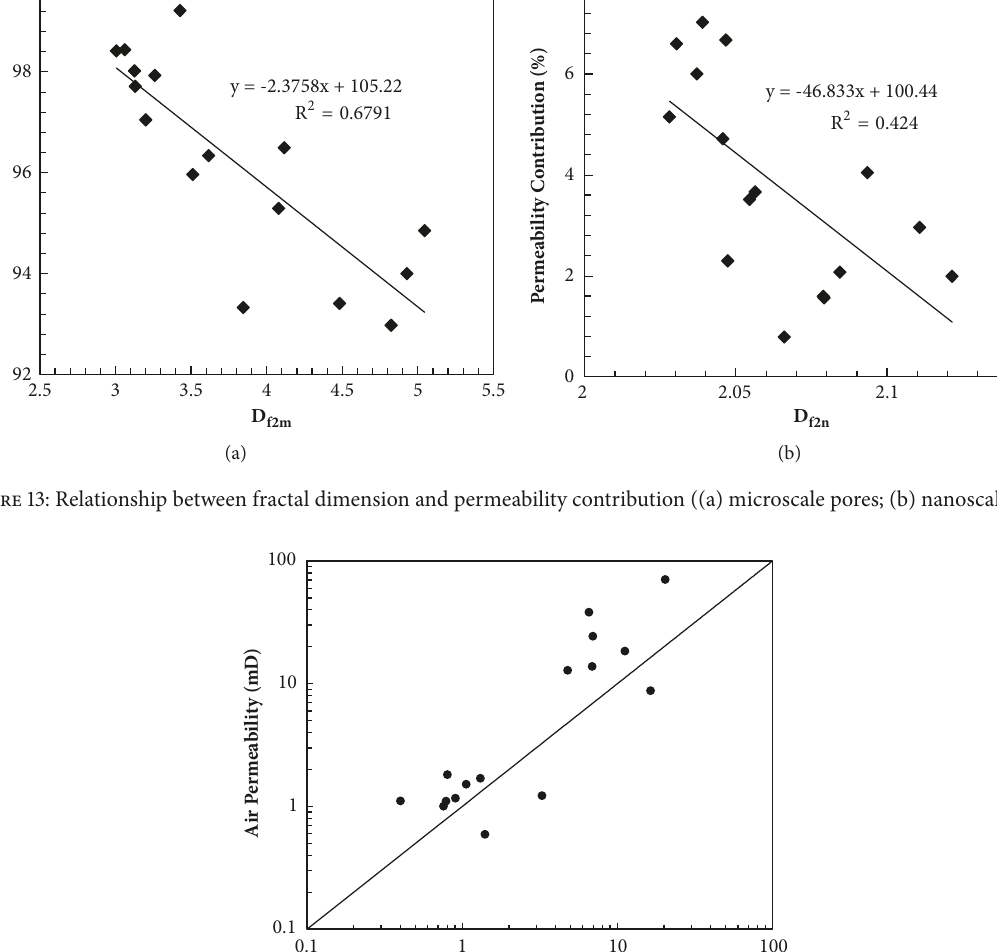
y = -2.3758x + 105.22